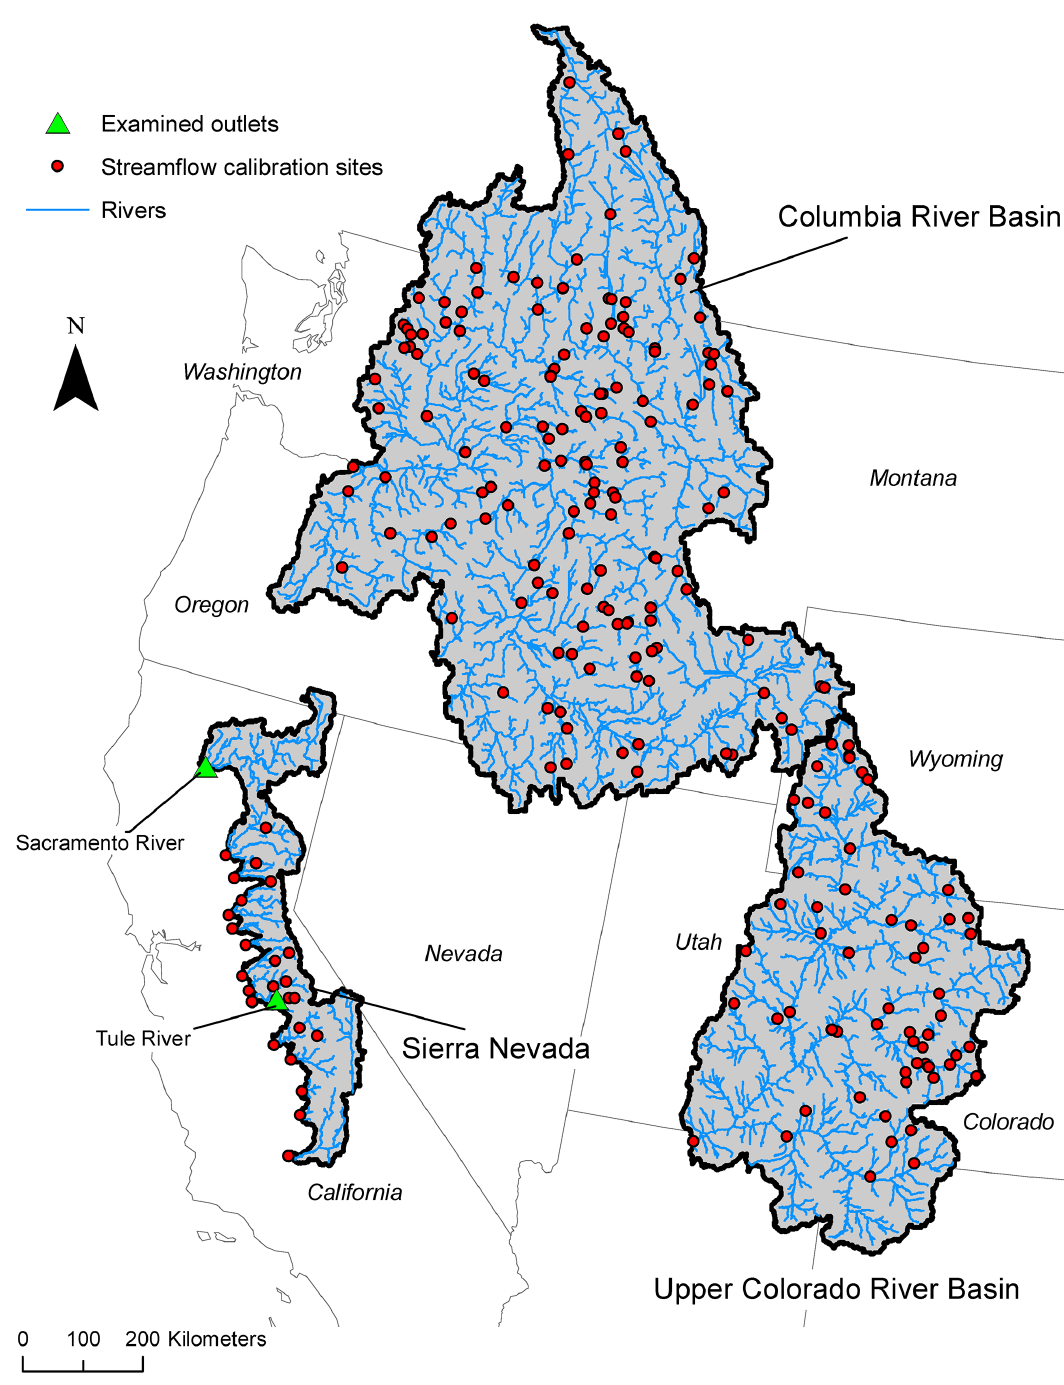
Figure 2. Streamflow locations used in this